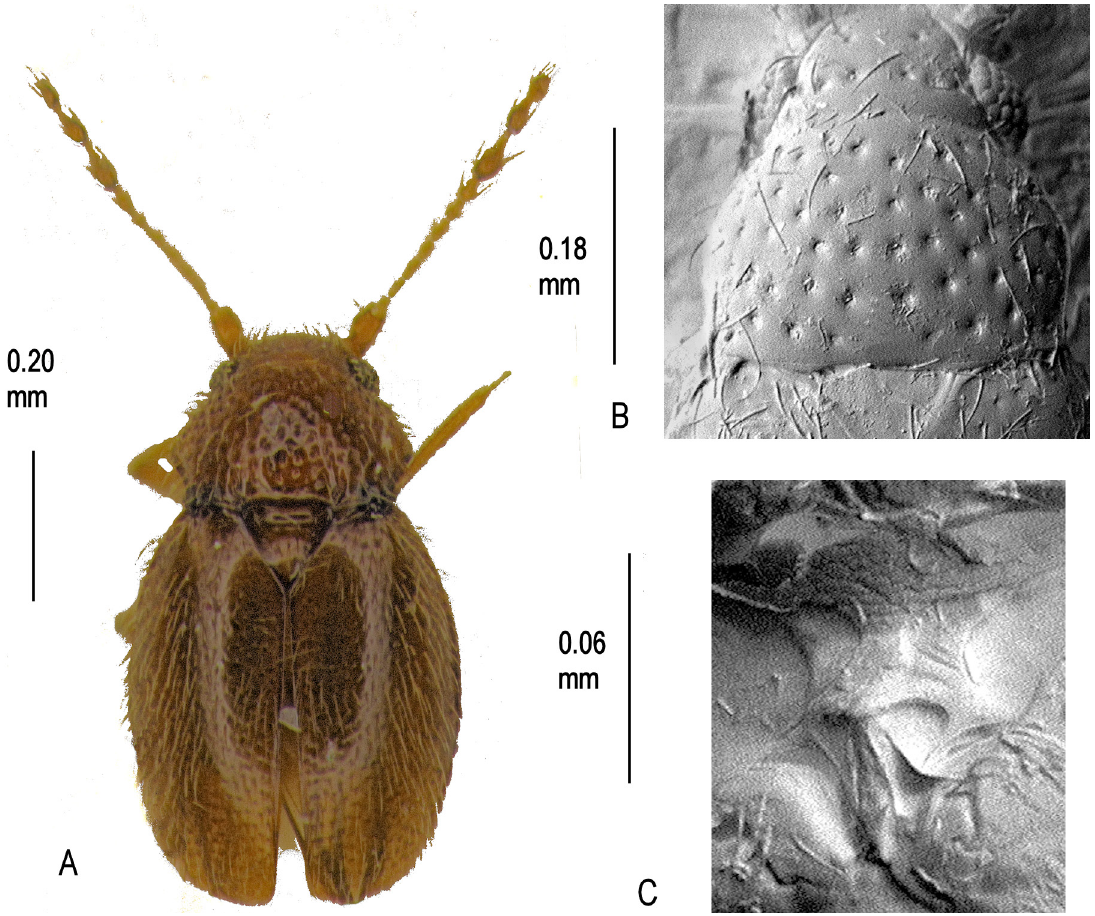
Fig. 62 . Cissidium werneri sp. nov. A . Habitus. B . Pronotum, × 570. C . Mesoventrite showing median process of collar, mid-keel and keel, ×